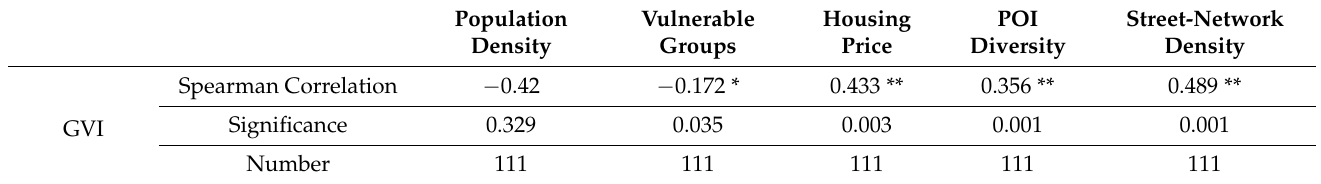
Table 4. Correlation analysis of green